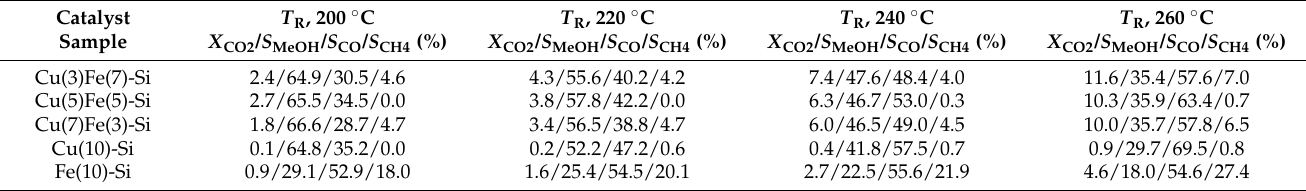
Table 5. Conversion/selectivity data ( X CO2 / S MeOH / S CO / S CH4 ) in the CO 2 hydrogenation reaction at dif-